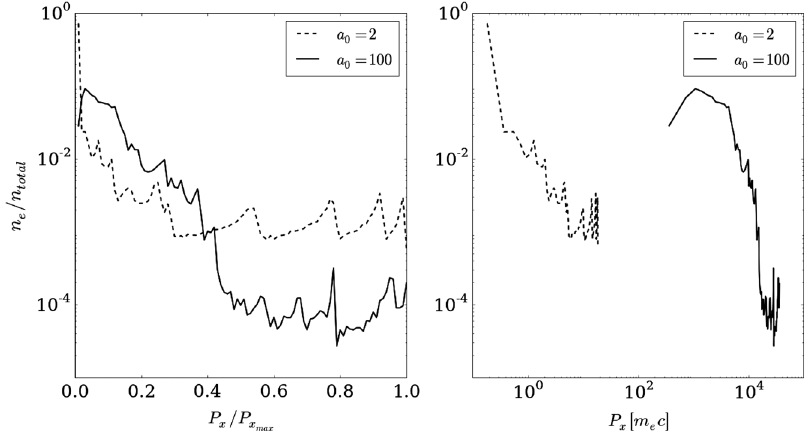
FIG. 6. The momentum spectra of accelerated particles, ultrarelativistic case with mass ratio ¼ 1 , (a) semilog and (b) log-log. The extended high energy spectra show peculiar